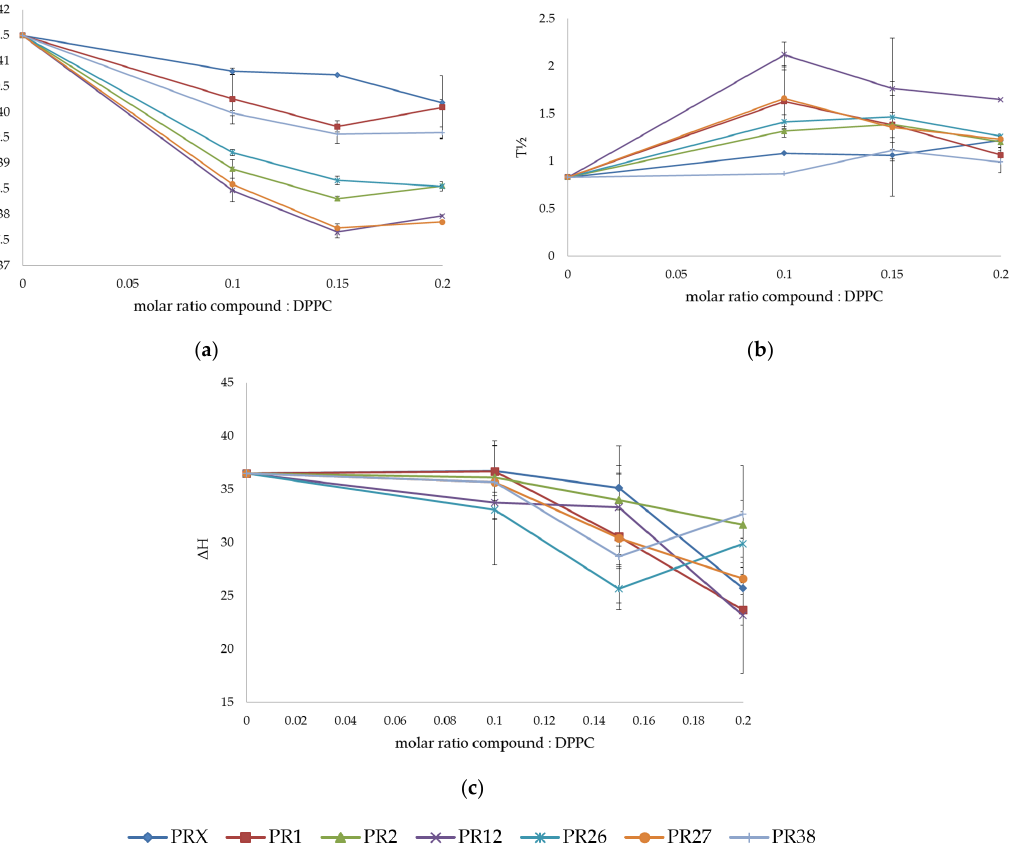
Figure 2. Influence of studied compounds on the parameters of DPPC main phase transition: temperature Tm ( a ), peak half ‐ width ∆ T 1/2 ( b ) and phase transition enthalpy ∆ H ( c ); mean ± SD, n = 8.